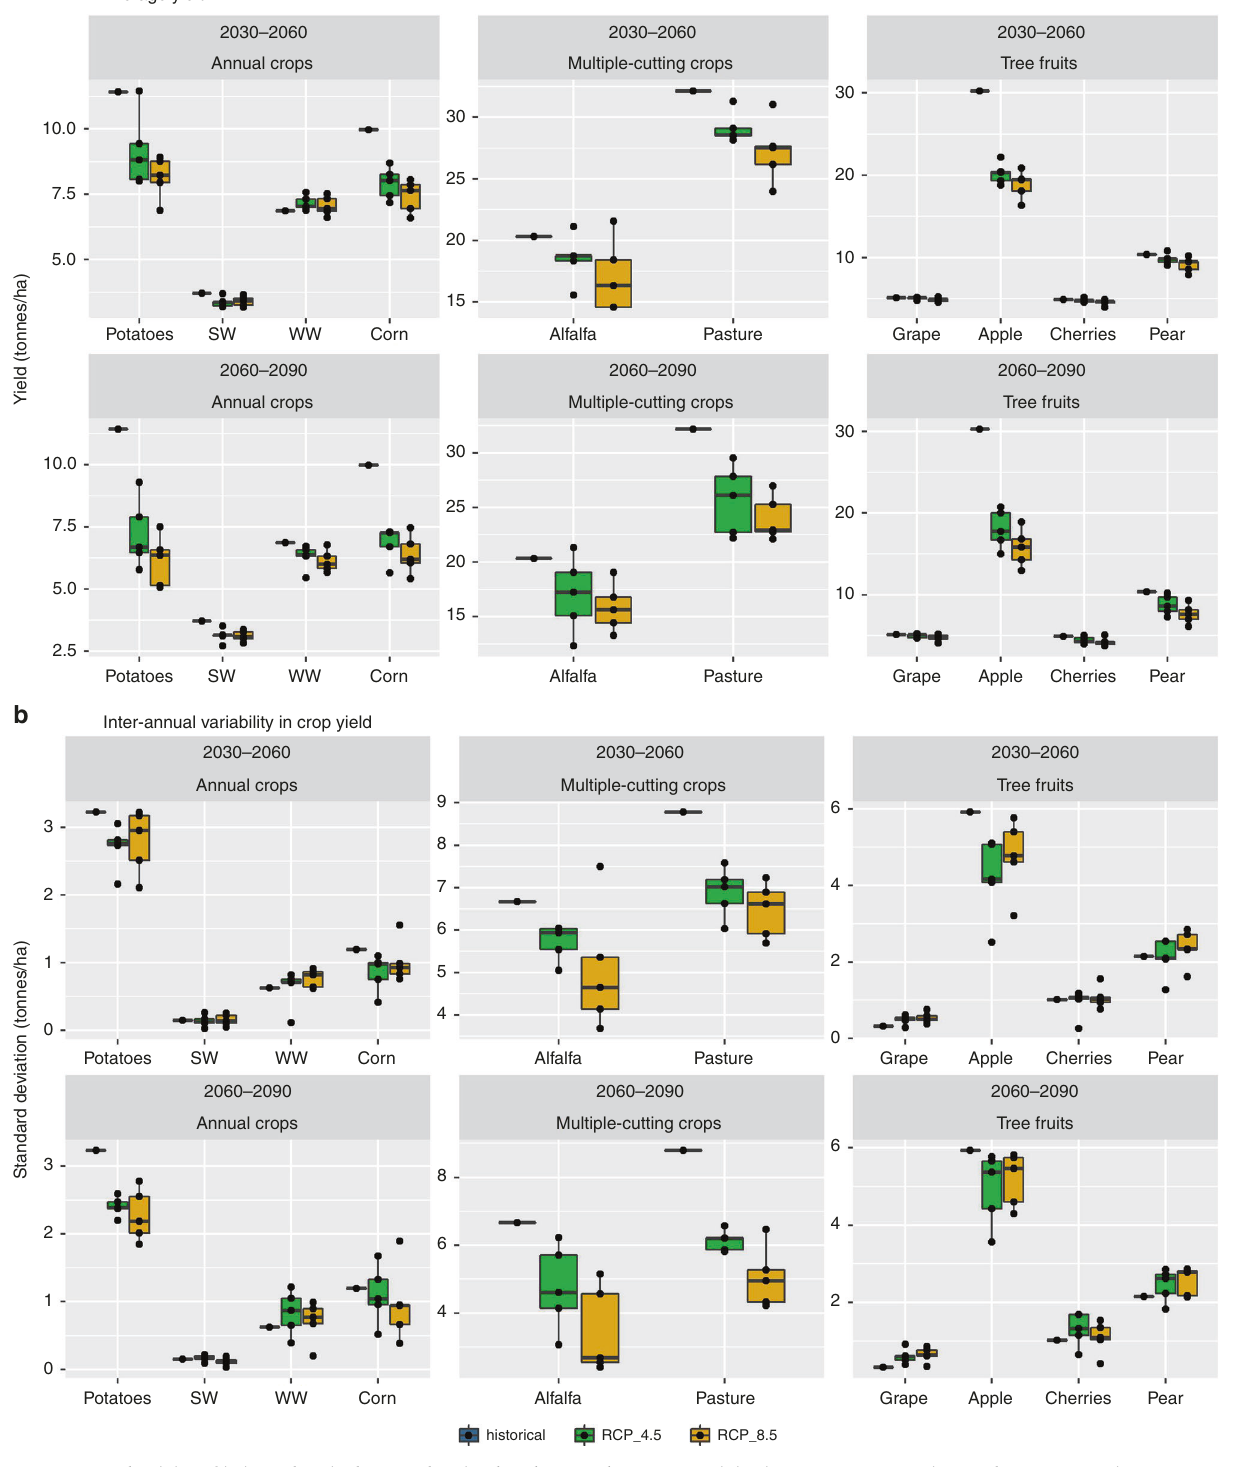
Fig. 2 Future productivity of irrigated agriculture under simulated water shortage, precipitation, CO 2 concentration, and temperature increases. Panel a shows average annual future yield and panel b shows standard deviation of annual agricultural yield. Crops have been categorized into three groups of annual crops (i.e., potatoes, winter wheat, spring wheat, and corn), multiple-cutting crops (i.e., alfalfa and pasture), and tree fruits (i.e., grapes, apples, cherries, and pears). Each panel has two rows that correspond to two different time periods: 2030 – 2060 and 2060 – 2090 (although the historical values are also included in both rows for comparison). The interquartile range in the boxplots is 50% (lower and upper quartile limits are 25% and 75%, respectively). The middle line in the boxplot represents the median, and the whiskers can span to 1.5 times the upper and lower interquartile ranges. Outliers (points) in this fi gure are numbers outside the whiskers. Also, in this fi gure, n = 10 30-year average and standard deviation of annual yield values for RCP 8.5 and 4.5 boxplots. Source data are provided as a Source Data fi